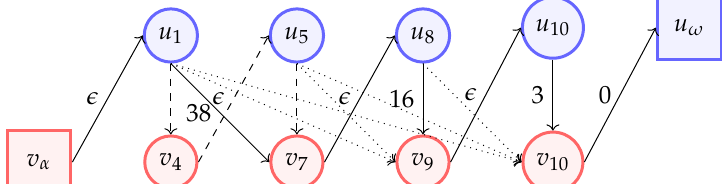
Figure 9. The directed acyclic bipartite graph for the previously provided example sequence, with weights ( w ) as given in Table 4. When (cid:101) = 0, the shortest path has a total cost of 57. This shortest path is marked using continuous lines as arcs between the vertices. Only the weight of the vertices for this shortest path and those equal to (cid:101) are shown. When (cid:101) = 8, the shortest path solution corresponds to the path v α → u 1 → v 10 → u ω (not shown) with cost 64 + (cid:101) =